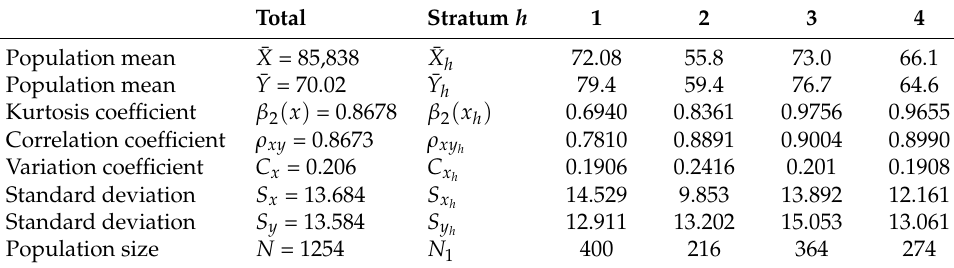
Table 1. Population 1 summaries.